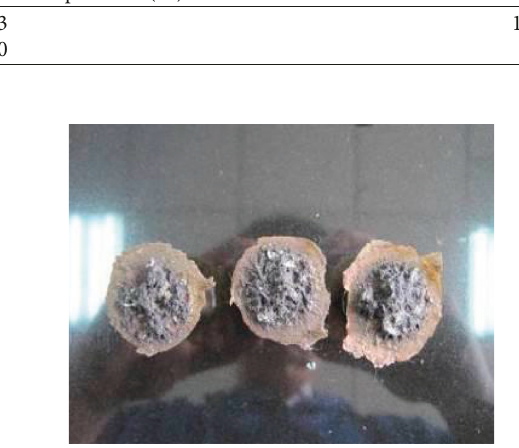
Figure 2: Fracture interface in pull-off test (70 °